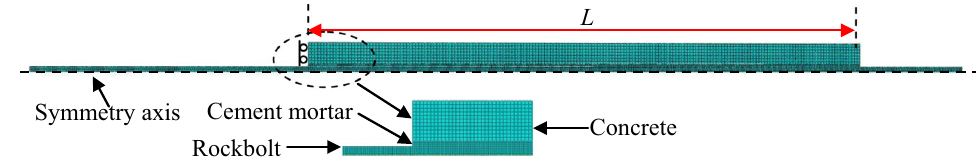
Fig. 8 Model setup for the grouted rockbolt systems